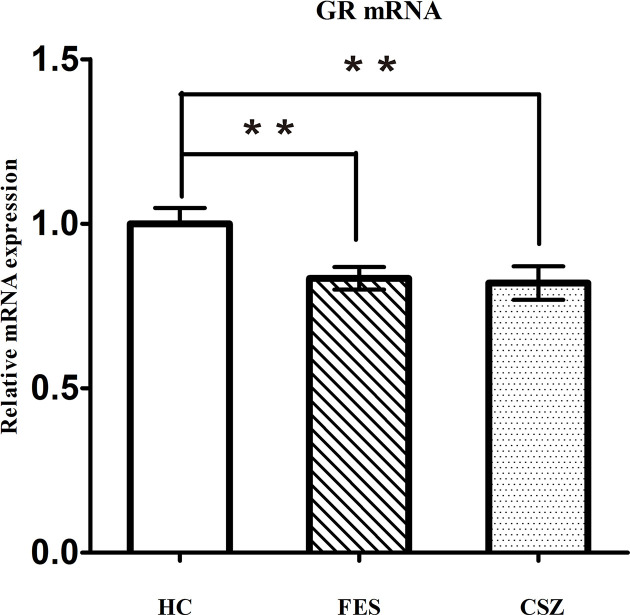
Representative of the relative mRNA expression of GR gene. ** means P < 0.01. Error bars denote mean and SD. FES, first-episode schizophrenia; CSZ, chronic schizophrenia; HC, healthy controls; GR, glucocorticoid receptor.